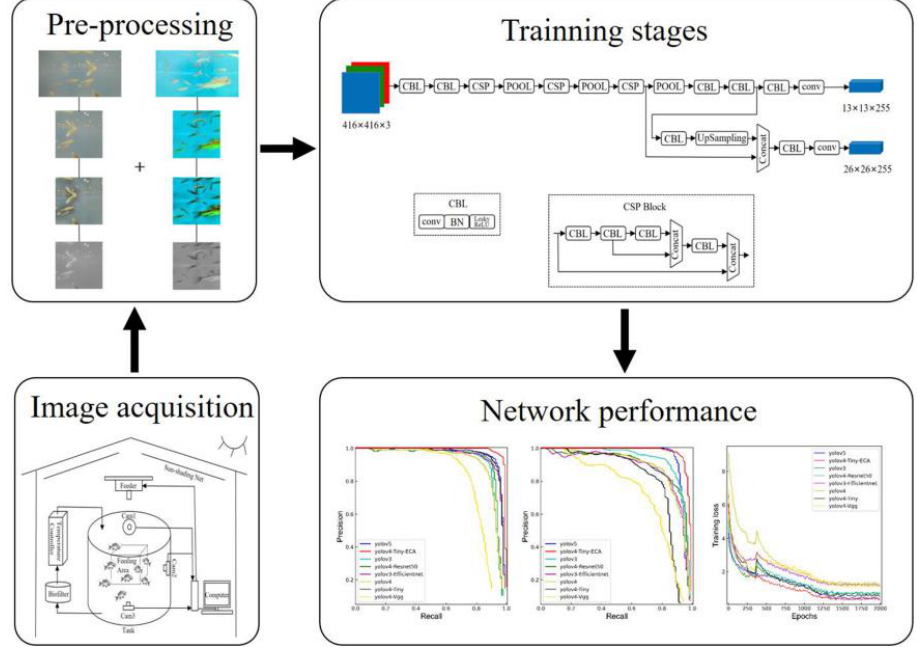
Figure 6. Schematic diagram of image acquisition, image preprocessing, and model training.